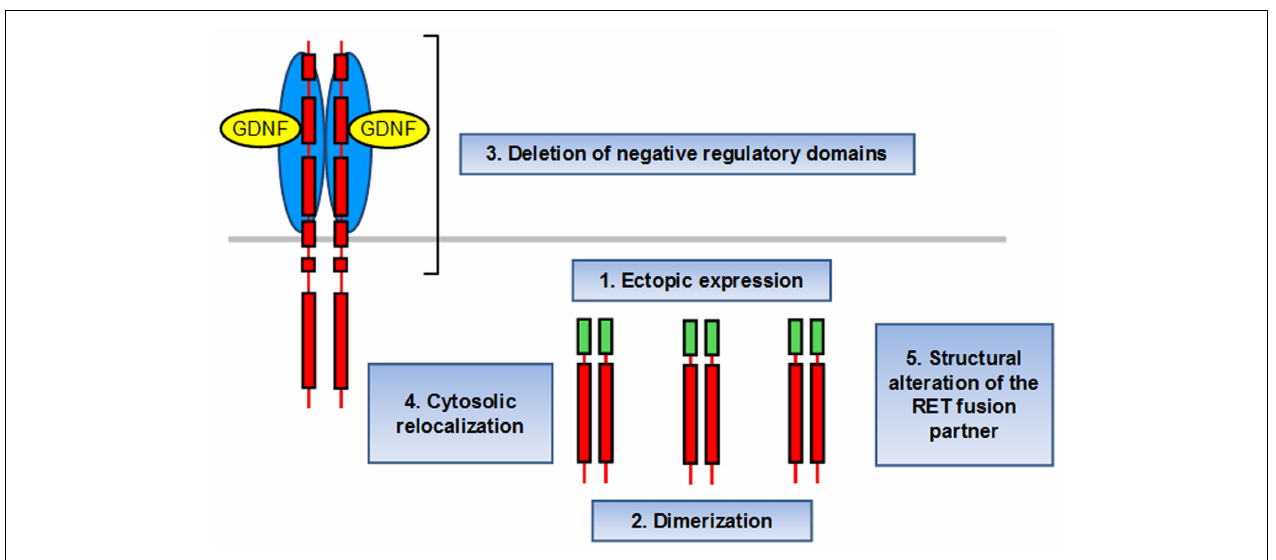
active conformation. (4)The delocalization of the rearranged protein to the cytosol abolishes receptor-mediated endocytosis and lysosomal degradation, leading to increased protein stability, and interaction with negative regulators located at plasma membrane level. (5) RET fusion genes appear to code negative modulators of transformation.Thus, their structural alteration might contribute to the oncogenic potential of the RET/PTC